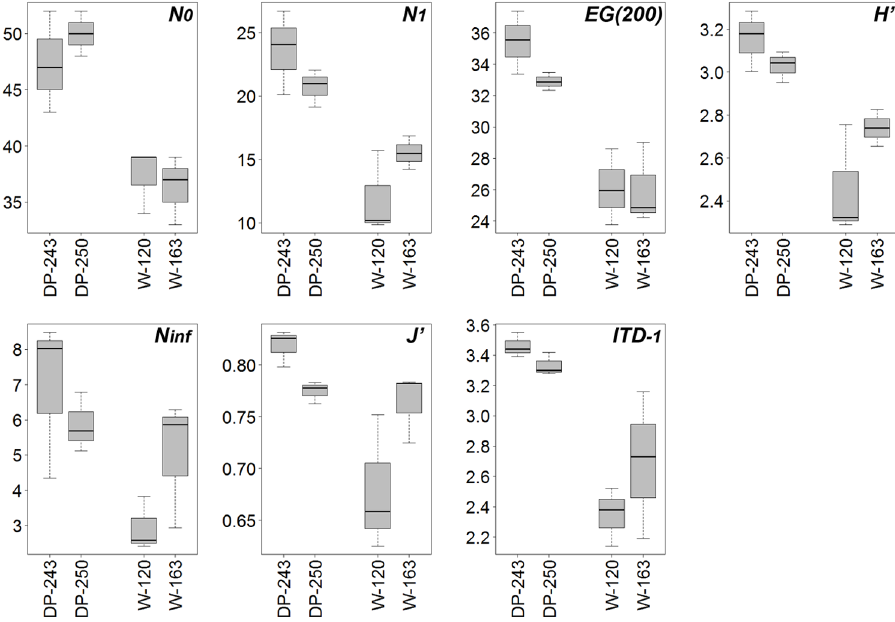
Fig 6. Box plots of the different diversity indices for the different stations. Boxes display median, first and third quartiles, minimum and